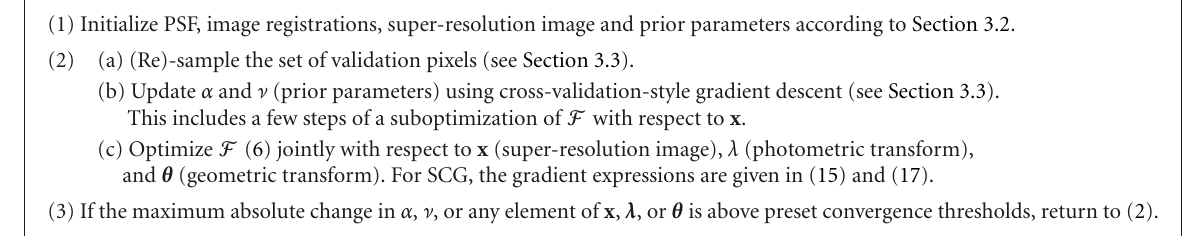
Algorithm 1: Basic structure of the multiframe super-resolution algorithm with simultaneous image registration and learning of prior parameter